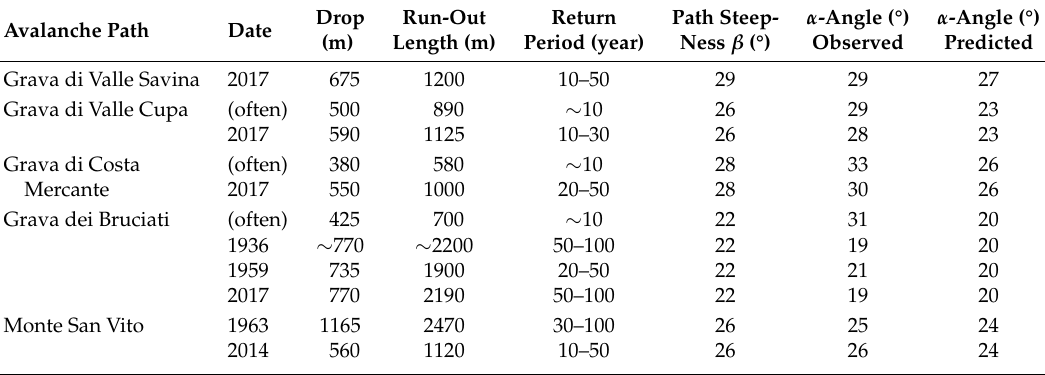
Table 1. Estimated return period, path steepness β , observed run-out angle α , and expected run-out angle for an extreme avalanche event according to the α - β model for Norway. Angles are rounded to nearest degree. Values for the 1959 avalanche in Grava dei Bruciati are rough estimates. The values for avalanches with return period of approximately 10 years are estimated from the extent of stands of bushes and very young trees near the centerline of the path. The date 1936 for the first known avalanche in the Grava dei Bruciati is not certain, and the run-out data are estimates based on the extent of damage.